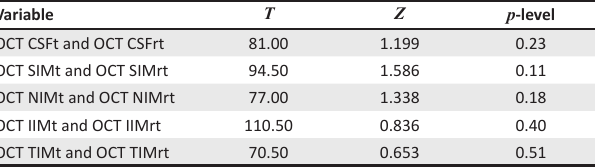
TABLE 5: The Wilcoxon matched pair hypothesis tests comparing test and retest measurements for the retinal thicknesses measurements within the macular region. Variable